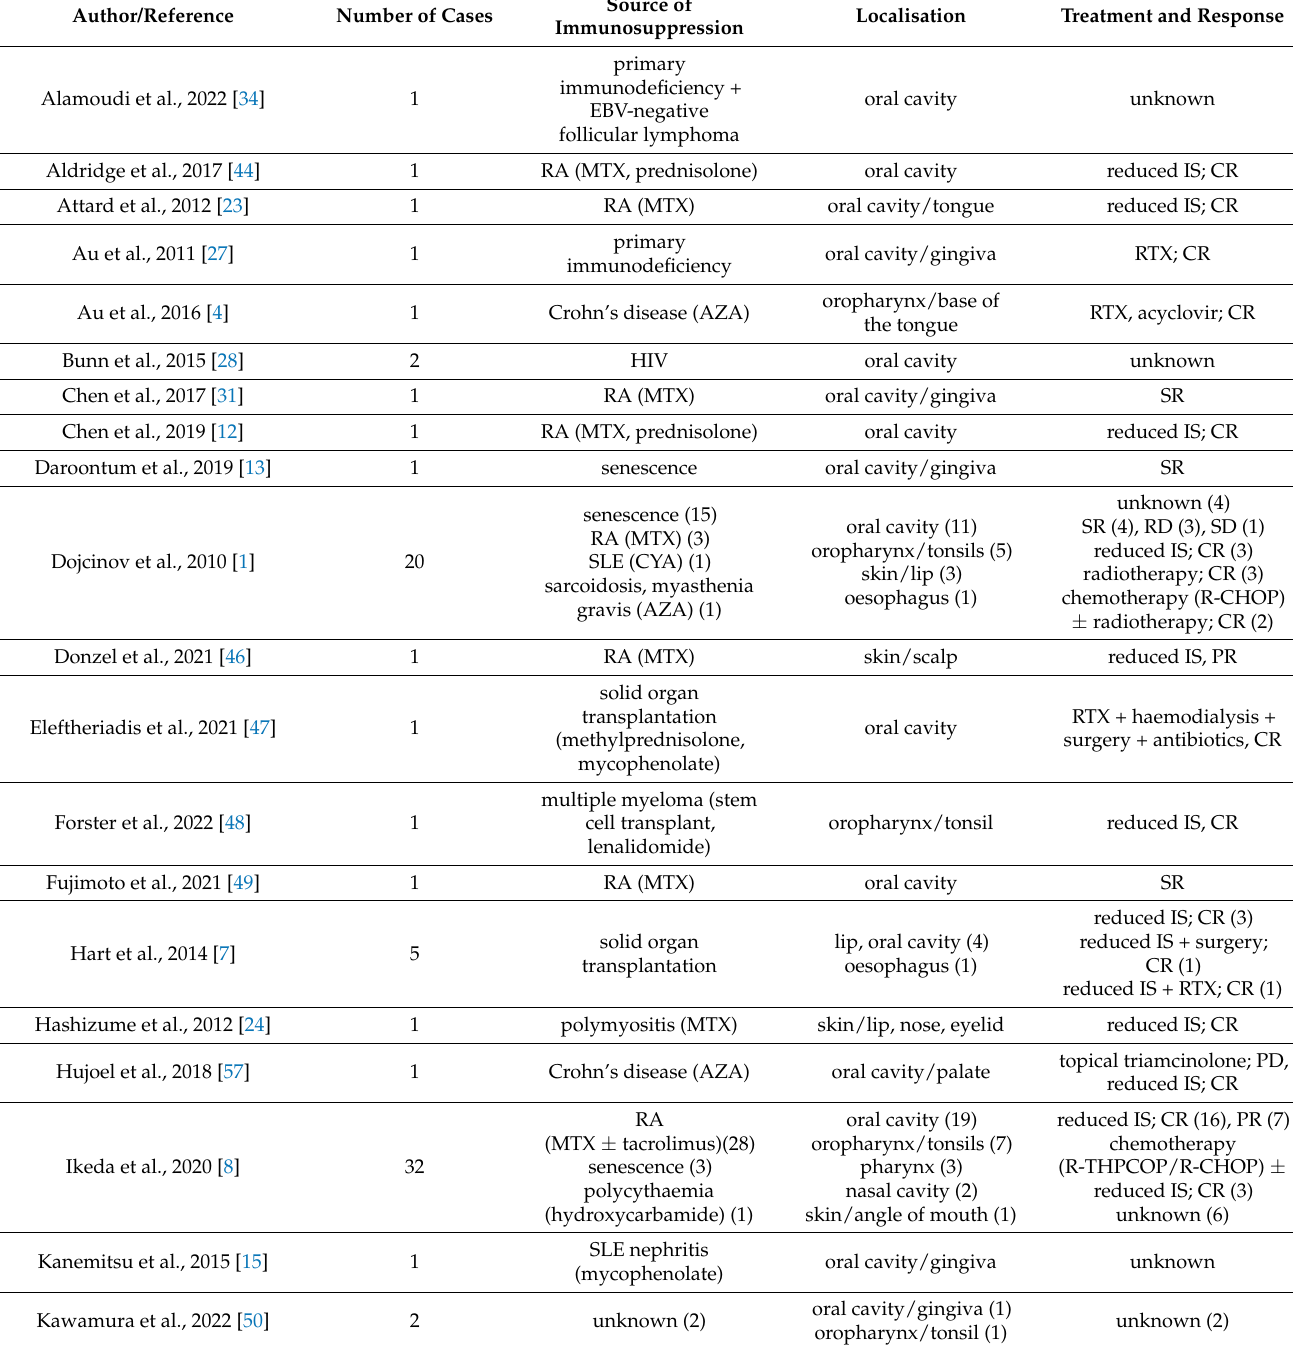
Table 1. Overview of EBV-MCU cases of the head and neck, including source of immunosuppression, localization, treatment and outcome